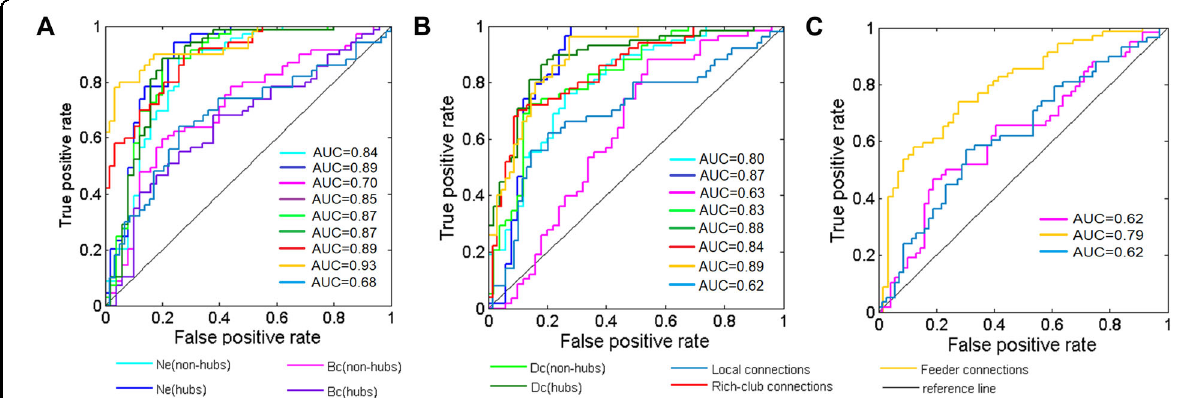
Fig. 4 ROC curves from the support vector machine (SVM) method using all topological properties to classify three groups. Nodal properties (non-hubs of Ne, Dc, Bc and their corresponding hubs), and connections (rich-club, feeder, and local) are selected as features. Combining pairwise comparisons A MDDSI vs CN, B MDDNSI vs CN, C MDDSI vs MDDNSI, ROC curves reveal feeder connections have a better classi fi cation effect for all indicators. CN, cognitively normal; MDDSI, major depression disorder with suicidal ideation; MDDNSI, major depression disorder with non- suicidal ideation; AUC, area under curve; ROC, receiver operating characteristic curve; Ne, nodal ef fi ciency; Bc, betweeness centrality; Dc, degree